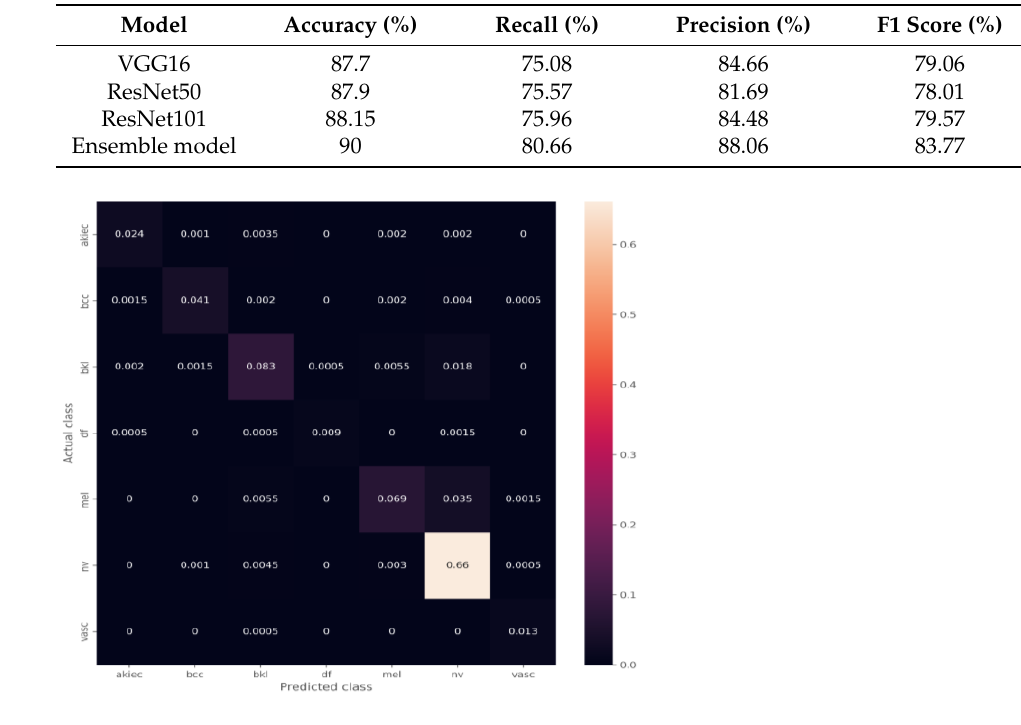
Figure 10. Confusion matrices of the ensemble model. Table 4. Class-wise performance of the ensemble models on balanced and unbalanced